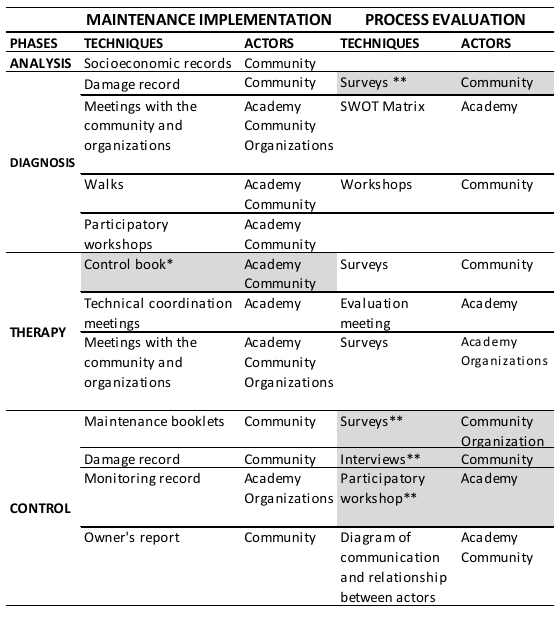
Table 1. Employed techniques during the preventive conservation phases. Source (Tenze, et al, 2019) In grey are shown the results that have been analyzed and respond to the objectives of this research. Some of the objectives to be (3) Enchancleado: a traditional ceiling made of earth and straw, and supported by a wooden structure. (Cardoso, Quizhpe & Achig, 2018)